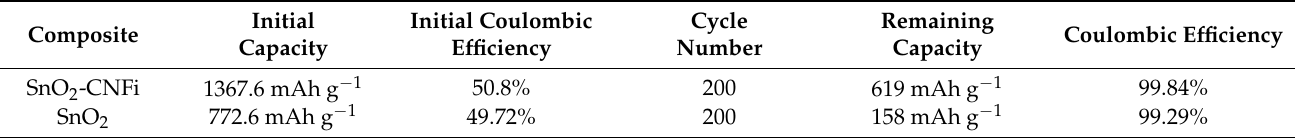
Table 1. Cycling performance capacities of SnO 2 -CNFi/SnO 2 in comparison at 100 mA g − 1